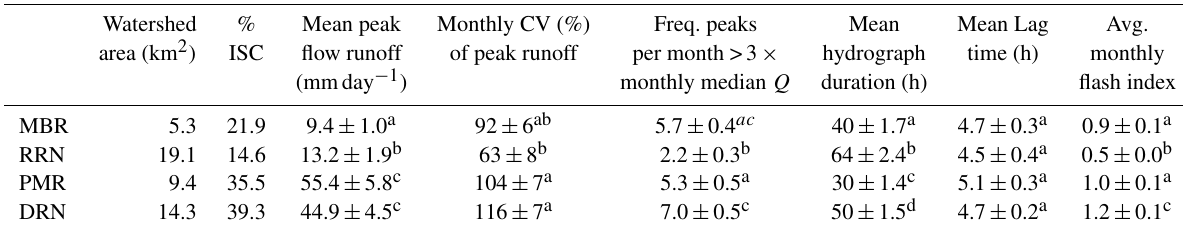
Table 4. Hydrologic flashiness metrics (mean ± SE). Watershed